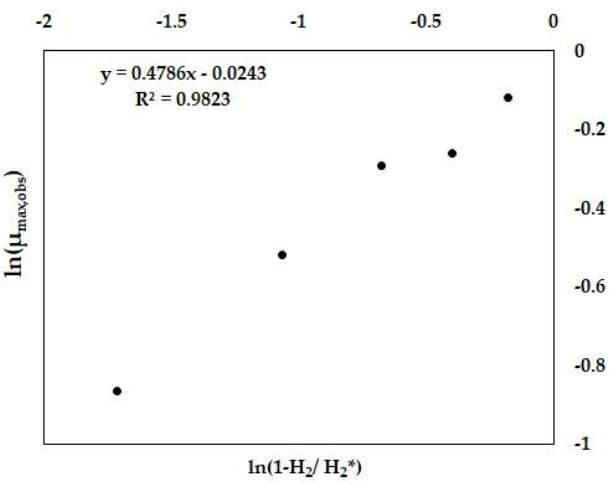
Figure 12. Determination of µ max , n, and H 2 * for product